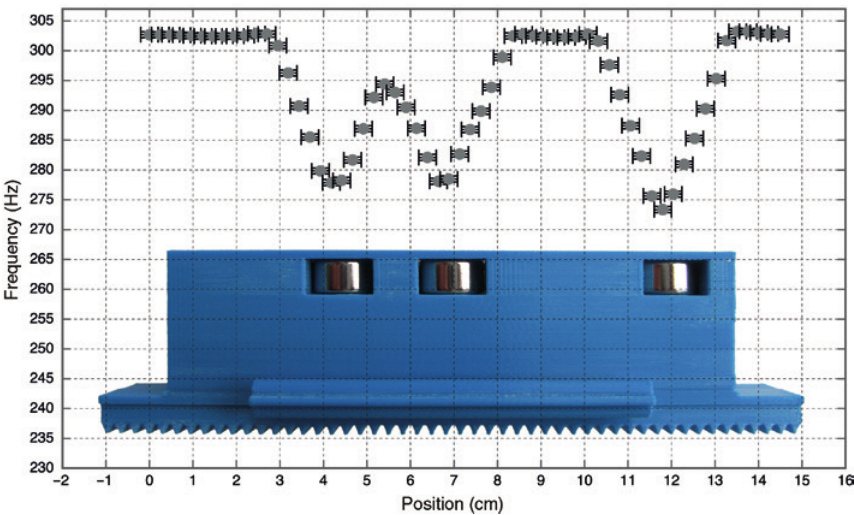
Figure 7: Analysis of a “01101”-bit pattern referring to a PMR medium (uniform magnets).